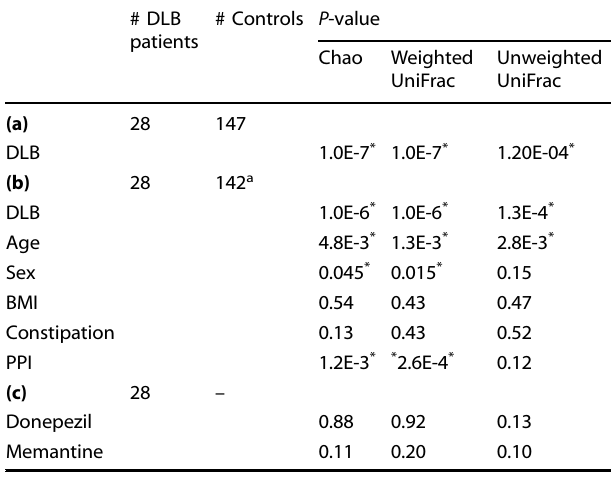
Table 2. PERMANOVA to examine the effect of each factor on the overall bacterial composition.